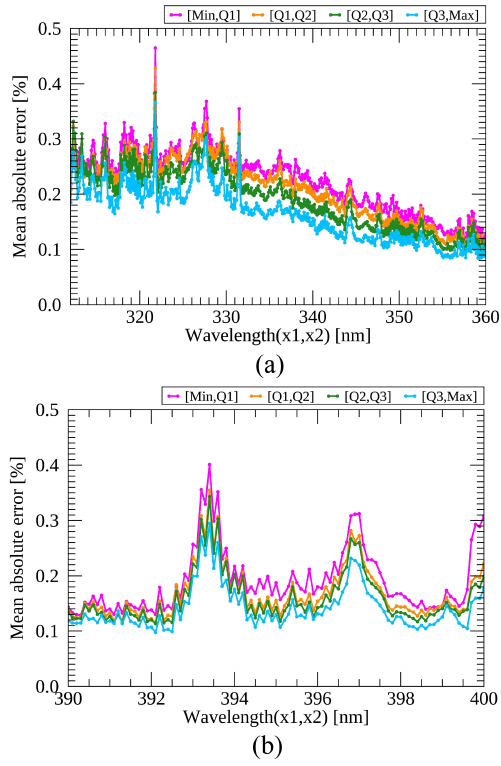
Figure 15. Mean absolute errors between the reproduced and mea- sured radiances at (a) ozone absorption and (b) Fraunhofer lines with the input case showing the smallest errors in Fig. 14. The Q 1, Q 2 and Q 3 represent the first, second and third quartile, and each color indicates the average in the range of each quartile. The x 1 and x 2 indicate wavelengths at the boundary of output spectral bands and the absolute error is calculated between the ML and GEMS ra- diances and divided by the latter in